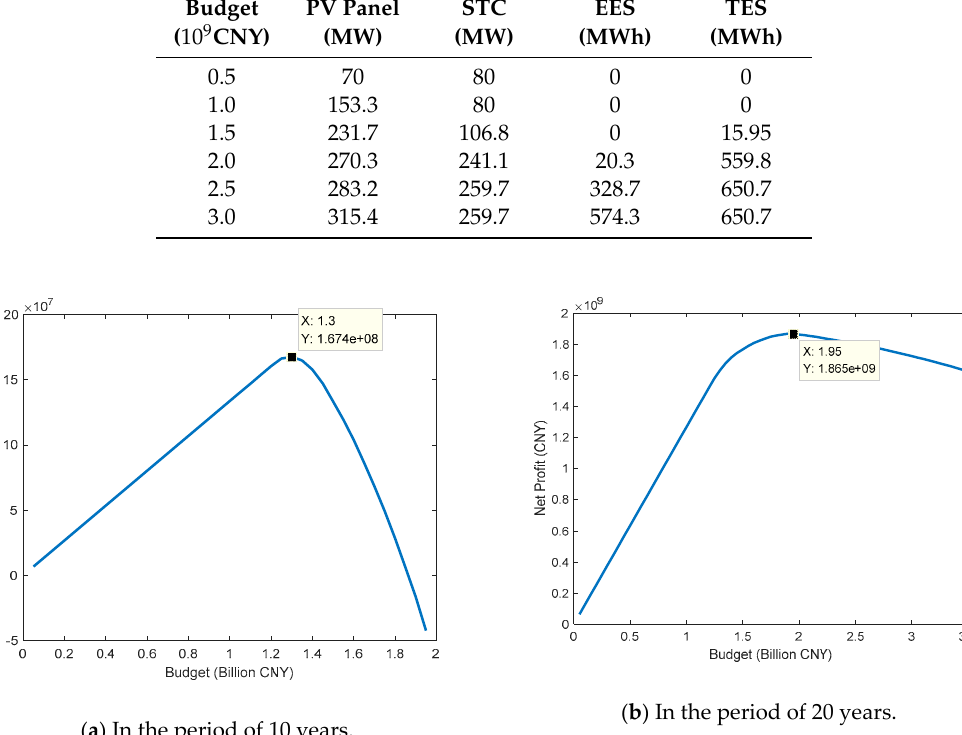
Figure 4. Relationship between budget and cost. Table 3. Optimal sizing strategies with different budgets.